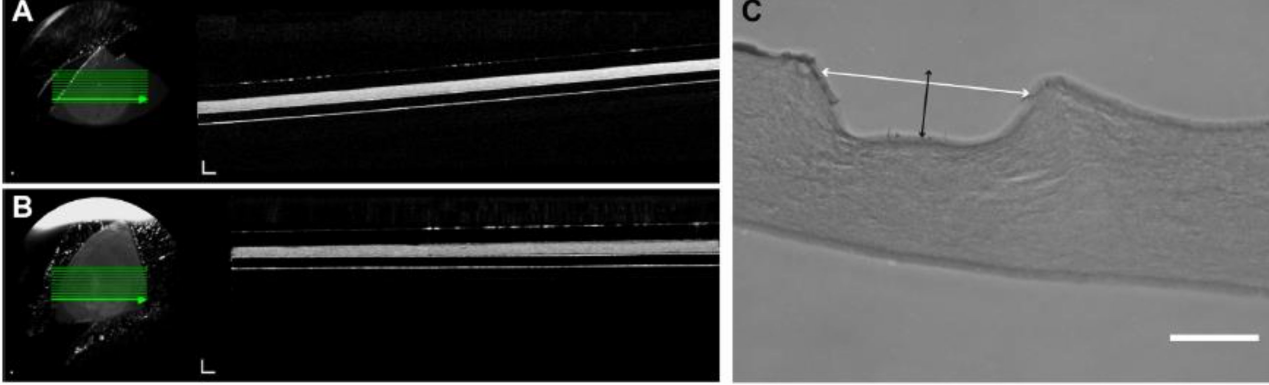
Figure 7. BLCs in RAFT constructs. ( A ) Shows a representation of an OCT image of an unfixed RAFT construct produced using an HPA. ( B ) Shows a representation of an OCT image of an unfixed RAFT construct produced using a RHPA. ( C ) Shows a representation of the H and E-stained section of a BLC on the surface of a RAFT construct. The white arrow shows width and the black arrow shows the depth measurements. Scale bars, C: 50 µ m